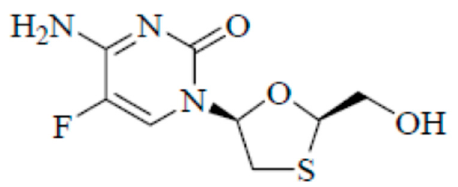
Figure 1. Chemical structure of emtricitabine (ECT).